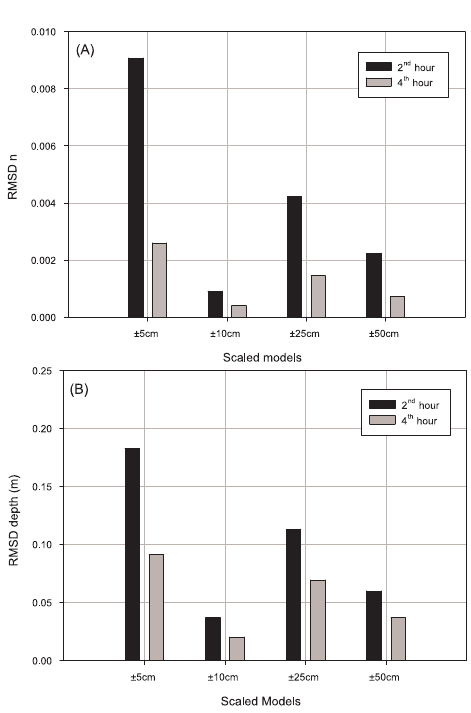
Fig. 7. RMSD values for (A) the roughness parameter and (B) depth derived results when different subscale scheme results ( ± 5, ± 10, ± 25, ± 50cm) are compared with those obtained using a reference scheme (Ref), for the 2nd and 4thh of the